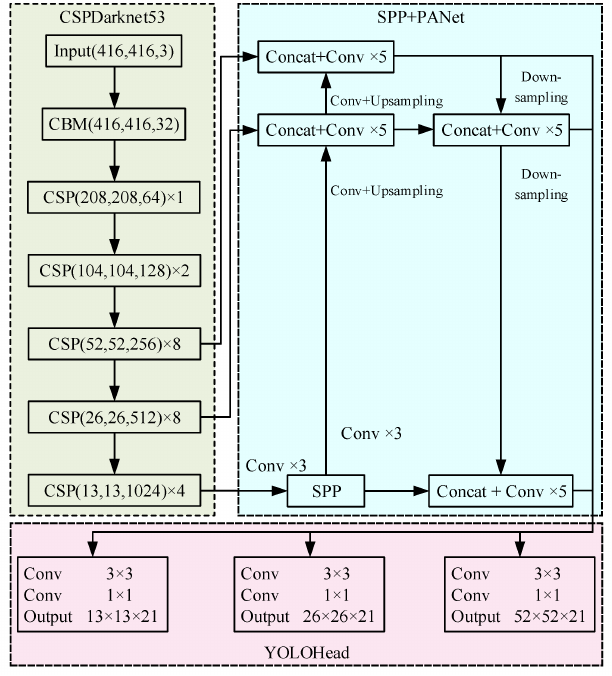
Figure 2. The structure of YOLOv4, source of the image: